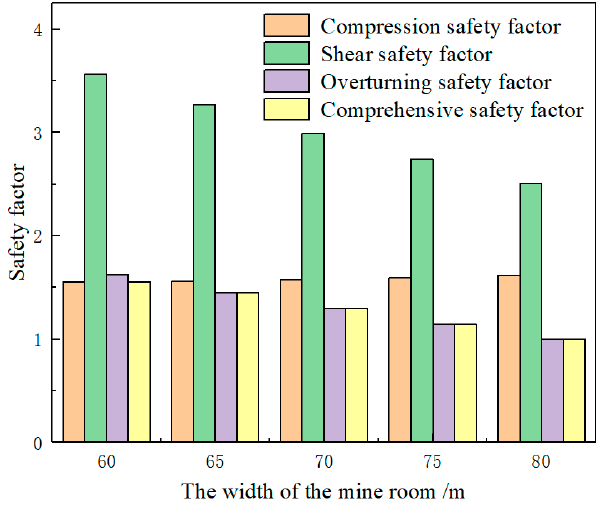
Figure 6. Relationship between safety factor and the width of the mine